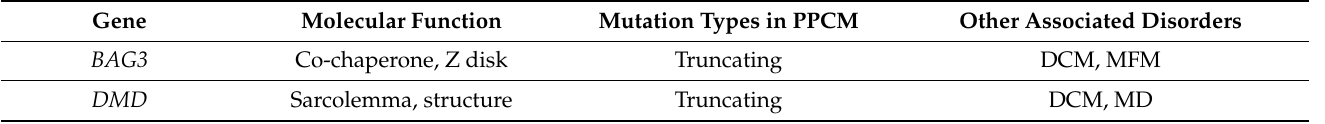
Table 1. Summary of genes associated with PPCM to date.